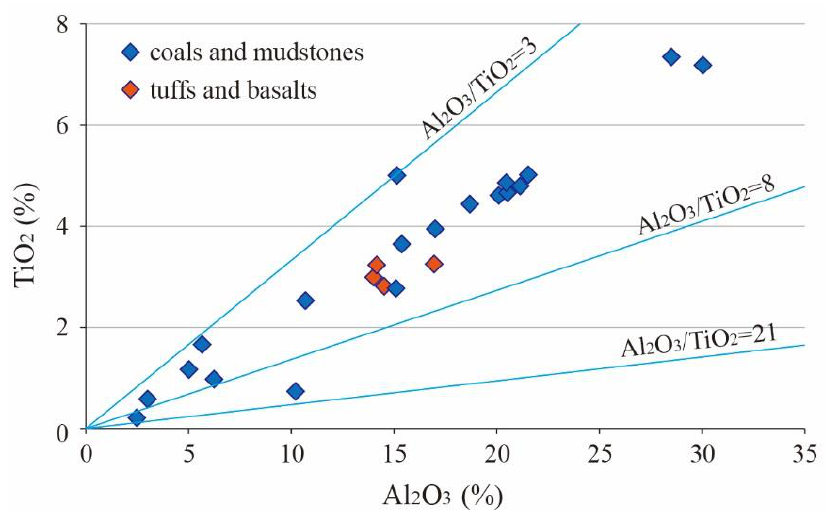
Figure 9. Distribution of ratios of Al 2 O 3 /TiO 2 . Note: The blue spots are coal samples, parting samples, roof samples, and floor samples of the C4-Upper and C5 + 10 coal seams. The red spots are tuff and basalt samples from the floor of the C5 + 10 coal seam.